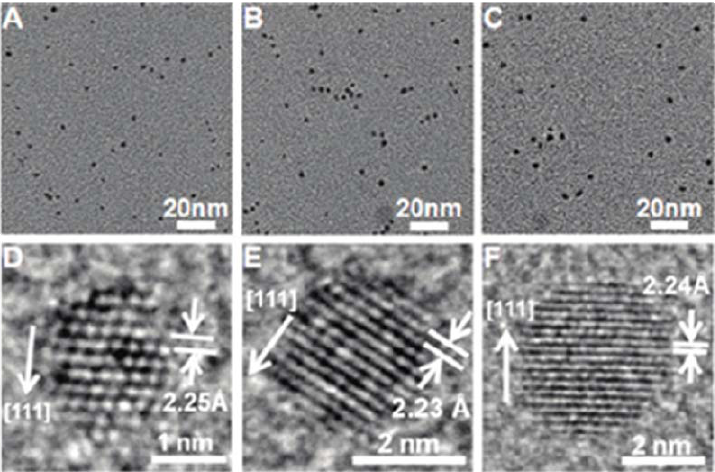
Figure 5. Ultra small platinum nanoparticles formed in the presence of platinum specific peptides, each image is taken at different time during nanoparticle formation, A (10s), B (60s) and C (5h). Reprinted with permission from [67]. Copyright 2009 American Chemical